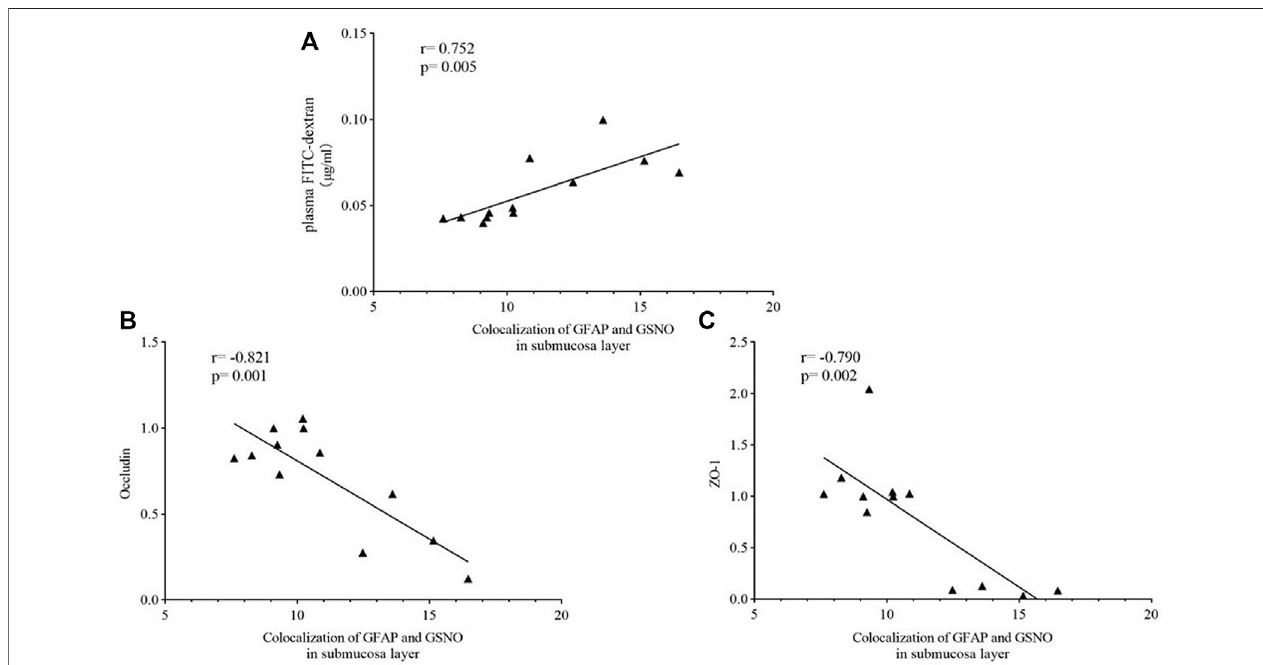
FIGURE 12 | Correlation analysis between the level of EGC-derived GSNO in the submucosal layer and intestinal barrier function. Spearman test showed that signi fi cant positive correlations were observed between the expression of EGC-derived GSNO and of plasma FITC-dextran concentrations in the muscle layer (A) . an inverse correlation was observed between the level of EGC-derived GSNO in the muscle layer and the expressions of occludin (B) and ZO-1 (C) .